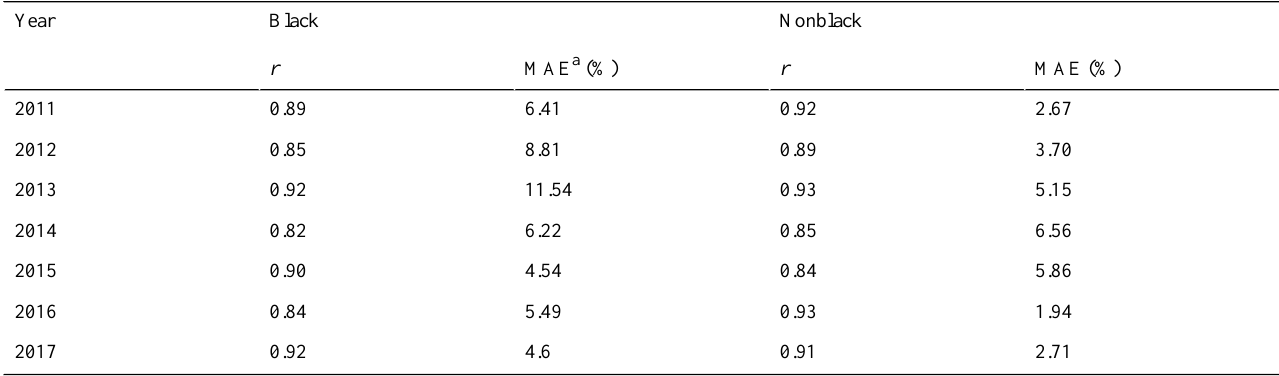
Table 3. Subgroup (race) prediction performance for gonorrhea. P <.001 for all r values. NonblackBlackYear